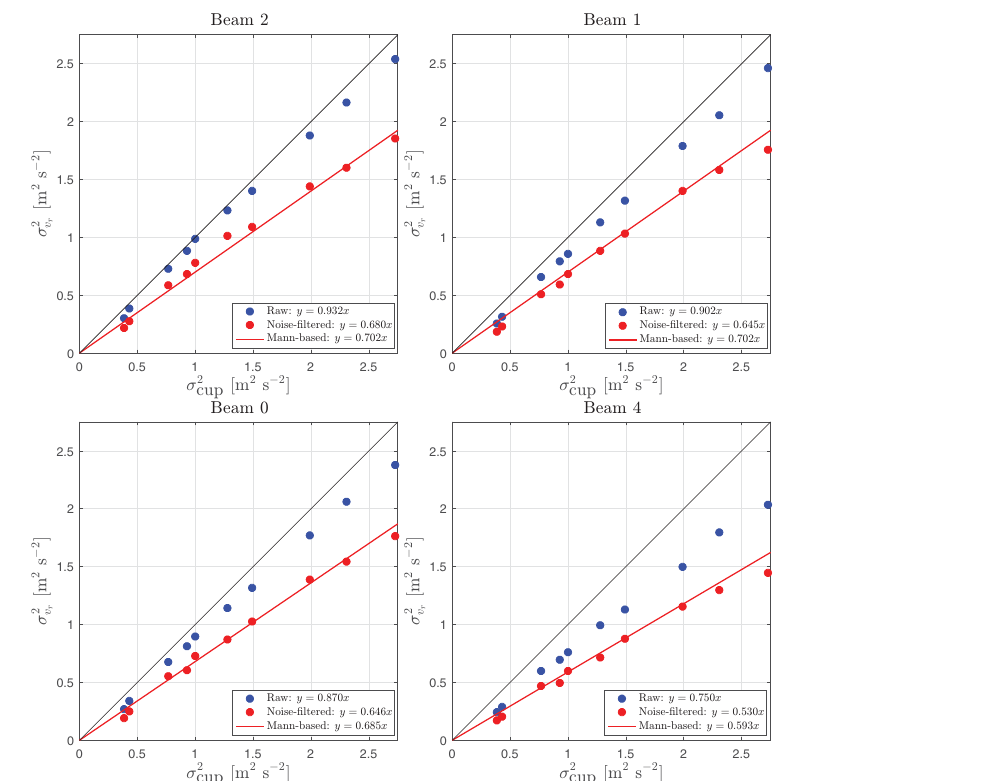
Figure 16. Comparison of the 80m cup anemometer with the Avent radial velocity variances for different beams for the 10 turbulence classes (filled circles) in Table 1. Raw and noise-filtered data are shown as well as a 1:1 line (for guidance) and the prediction of the Avent filtered radial velocity variance based on the Mann model, using (cid:48) = 3 . 00, L = 35 . 38m, and β = 0 ◦